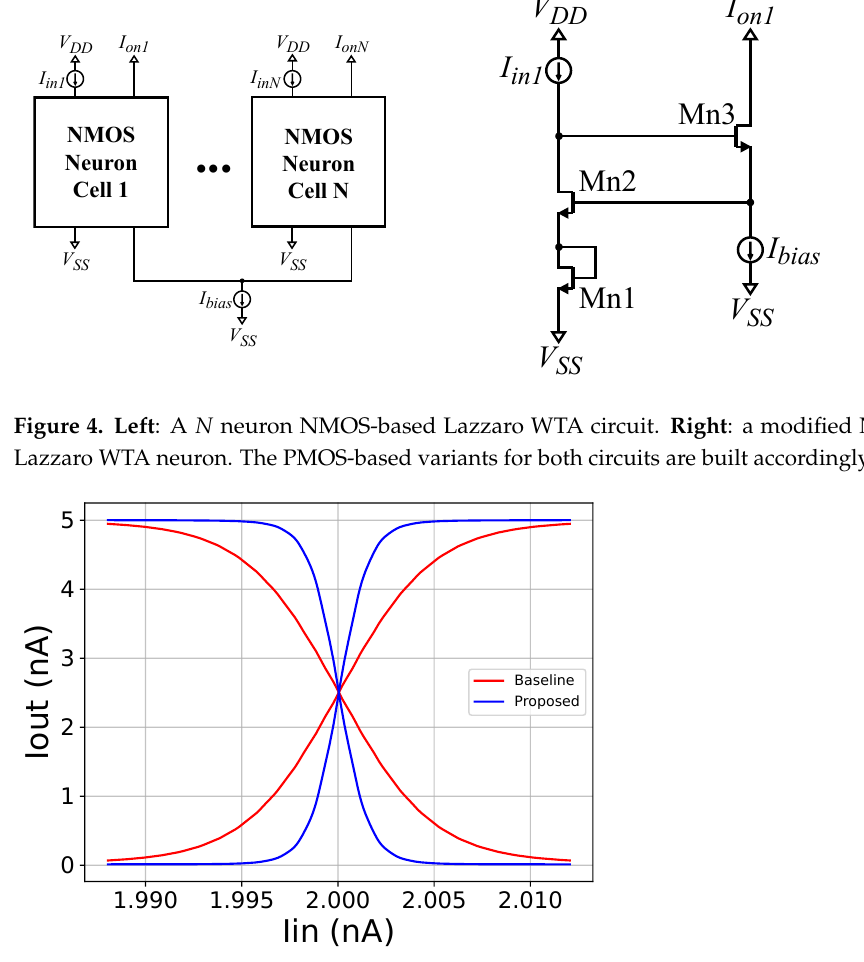
Figure 5. Comparison between the baseline cascaded WTA and the proposed cascaded WTA circuits with the added diode-connected